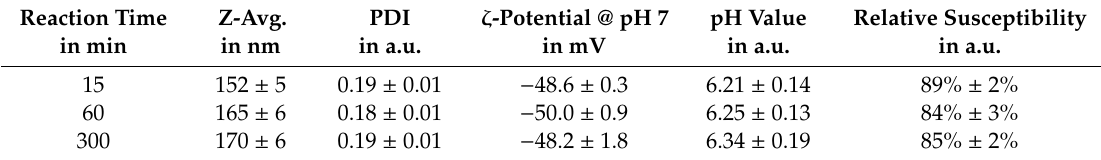
Table 3. Comparison of the basic parameters of Cit-Au-SPIONs with varied reaction times. Reaction Time Z-Avg. in min